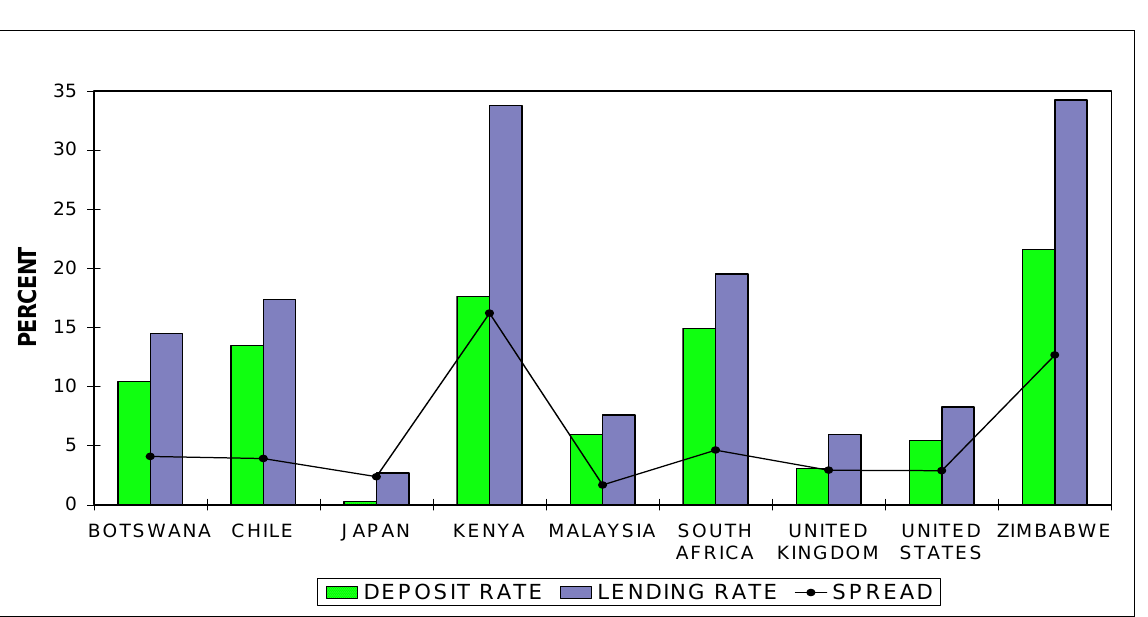
Interest rates and spreads in 1996 for selected